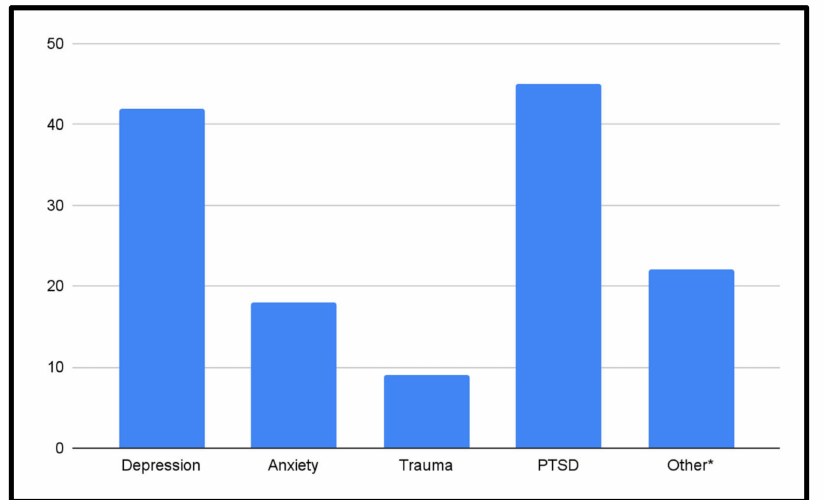
Figure 6. Overview of mental health conditions assessed among refugees and asylum